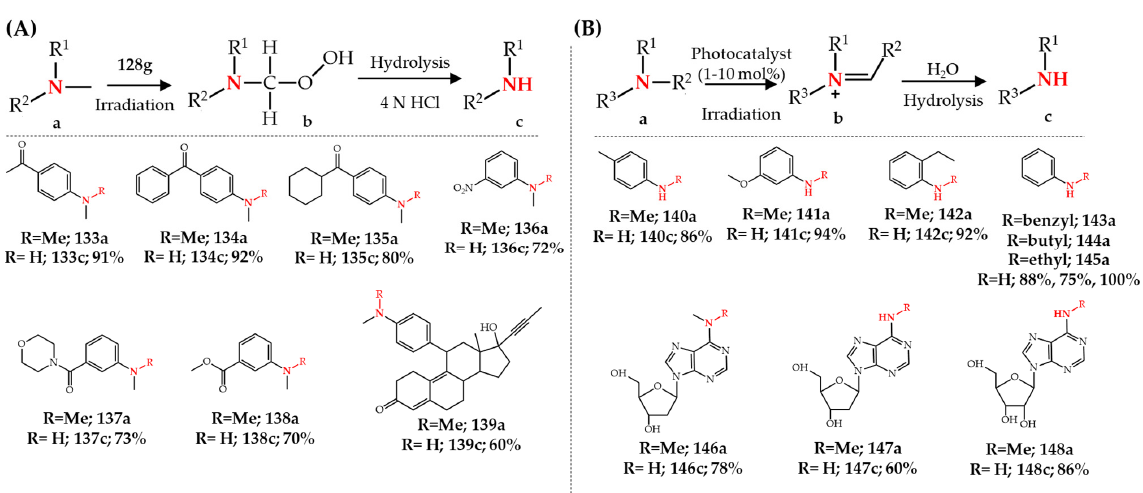
Figure 19. ( A ) Two ‐ step photochemical N ‐ demethylation of tertiary N ‐ methylamines and ( B ) pho ‐ tochemical N ‐ demethylation of secondary amines.